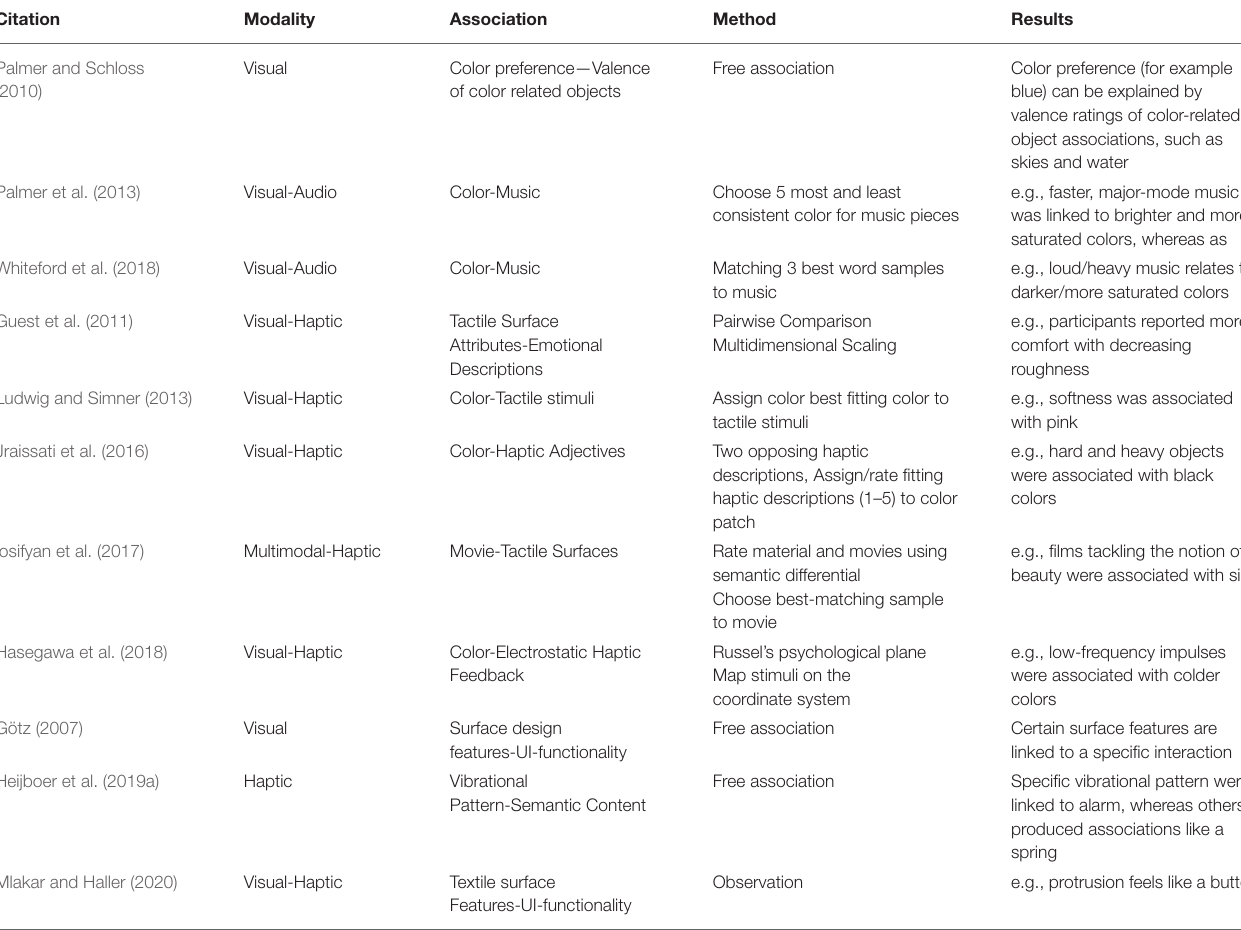
TABLE 1 | A brief overview of studies that are compatible with the aesthetic association principle as proposed by Fechner in the year 1866 (Ortlieb et al.,